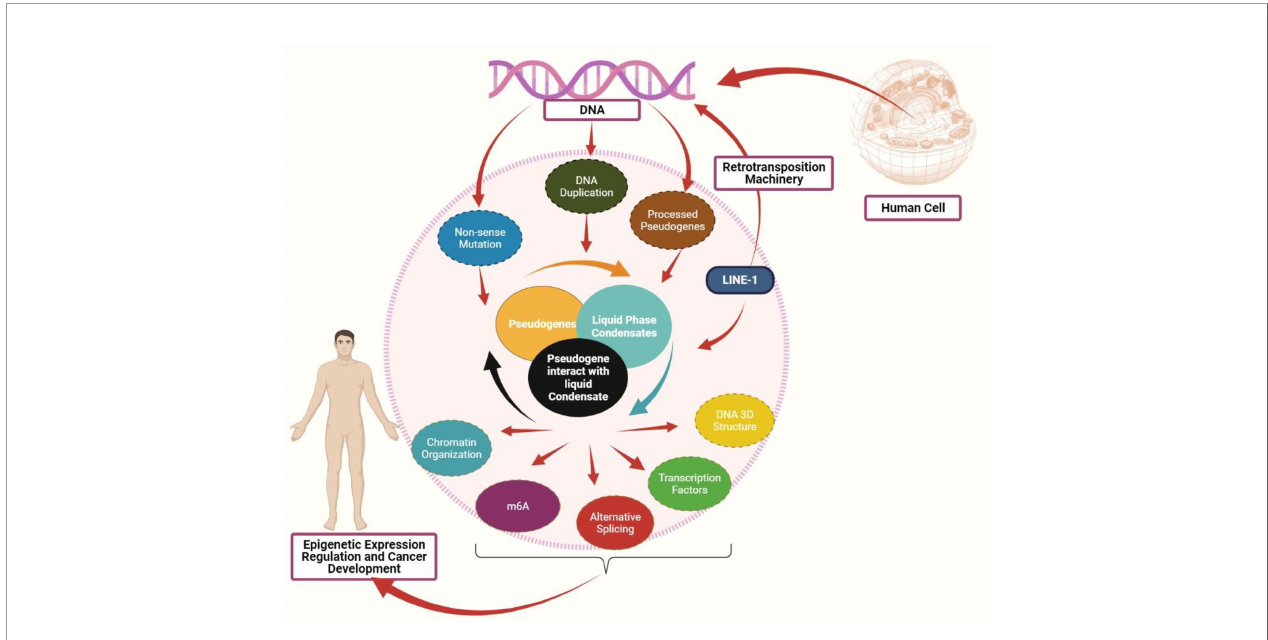
FIGURE 1 | Interaction between pseudogenes and LLPS to mediate cancer: Pseudogenes can be produced in three processes: pseudogenes due to nonsense mutation, pseudogene due to DNA duplication, and processed pseudogenes as the result of retrotransposition machinery. Both LINE-1 and pseudogenes can mediate the liquid phase condensates formation. A defect in pseudogenes expression may affect the liquid phase separate process, eventually affecting the epigenetic mediators, including chromatin organization, DNA 3D structure, transcription factors, alternative splicing, and m 6 A modi fi cation. Abnormal expression in these epigenetic mediators promotes cancer